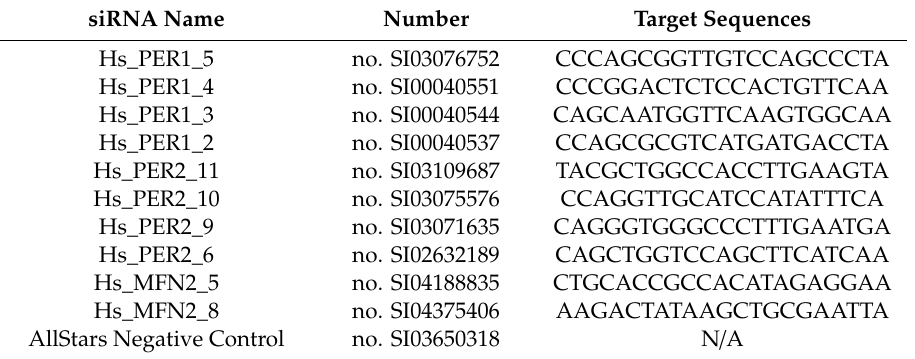
Table 1. siRNA target